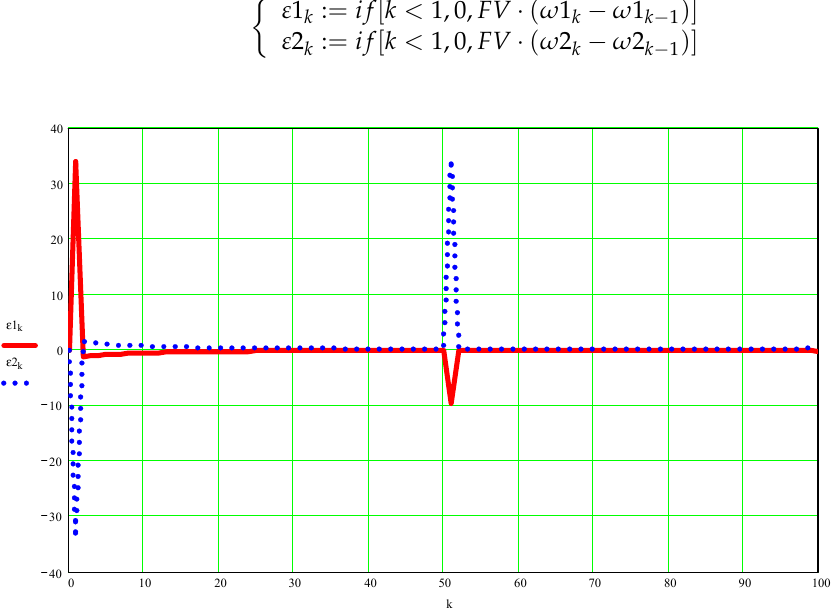
Figure A5. Values of angular accelerations ε 1 and ε 2 (in hertz 2 ) as a function of the independent variable k.